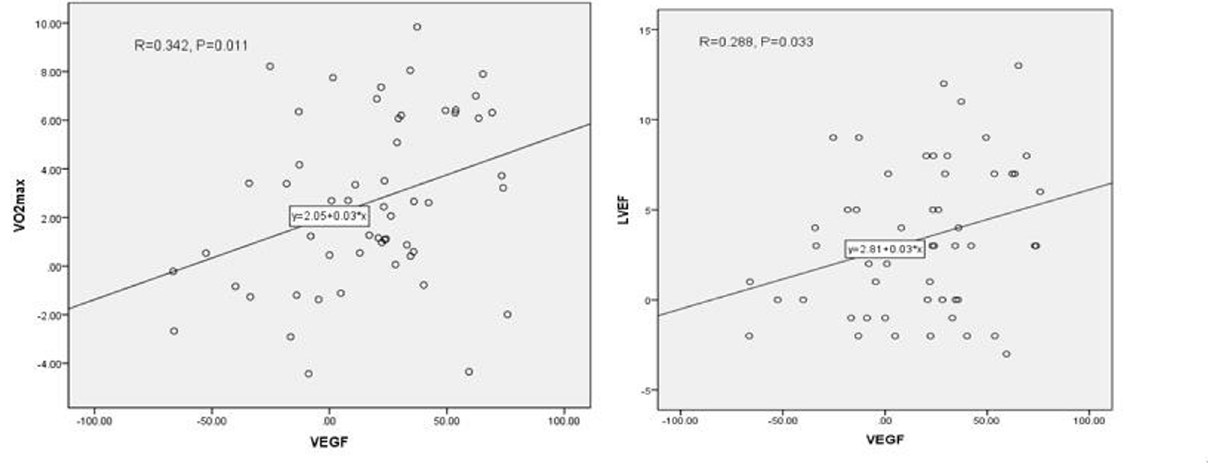
Figure 6 ： Correlation analysis of VEGF level and the cardiac